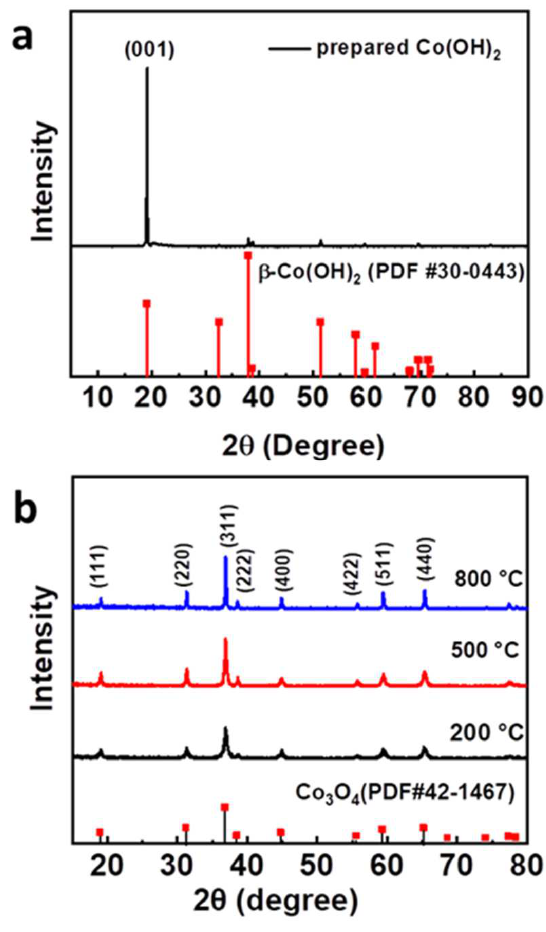
Figure 1. XRD patterns of ( a ) Co(OH) 2 and ( b ) Co 3 O 4 . SEM was applied to observe the morphology of samples obtained at the different annealing temperatures. The SEM image in Figure 2a confirms that the precursor Co(OH) 2 presents a hexagonal plate shape with a smooth surface, which is consistent with the previous study [39]. After the thermal decomposition of Co(OH) 2 nanoplates at 200 ◦ C for 30 min, a black powder was obtained. As shown in the SEM image in Figure 2b, the obtained Co 3 O 4 -200 remains in the shape of a hexagonal plate with a size range of 2–15 µ m. Compared with Co(OH) 2 , cracks on the surface of the black samples can be observed due to the evaporation of water produced in the process of the thermal decom- position of Co(OH) 2 . In addition, the cracks are supposed to increase the surface area, and should eventually enhance the adsorption capacity and catalytic capacity. The surface structure of the samples hardly changed at the temperature of 500 ◦ C (Figure 2c). As the temperature increased to 800 ◦ C, pore structures were produced due to the fusion and recrystallization of the samples in the process at a high calcination temperature (Figure